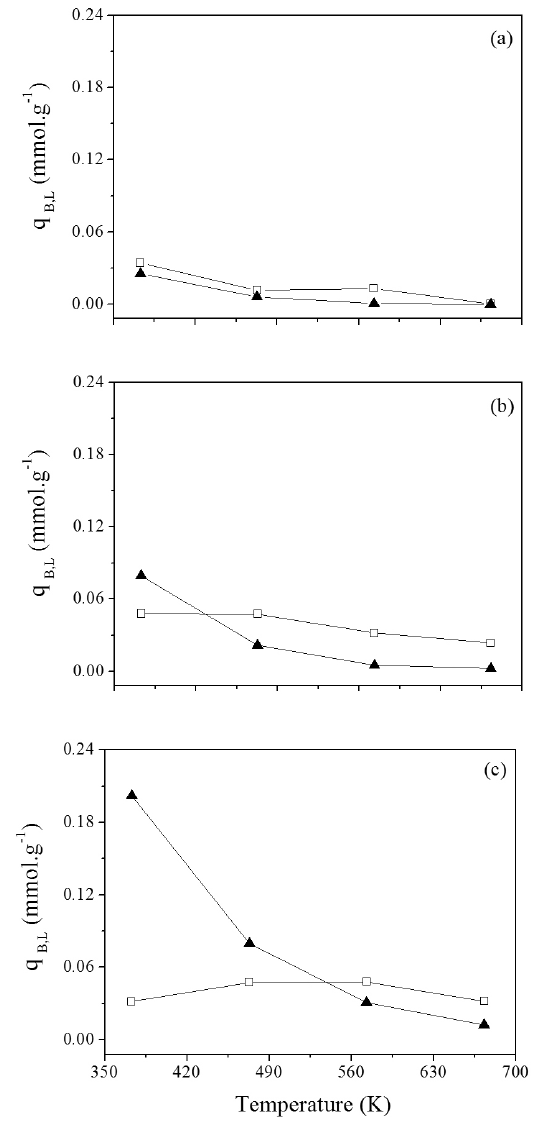
Figure 4. q , (mmol.g –1 ) vs. Temperature (K) of measurement B,L of the Brönsted acid sites (– □ –) and Lewis (–  –) of the samples: